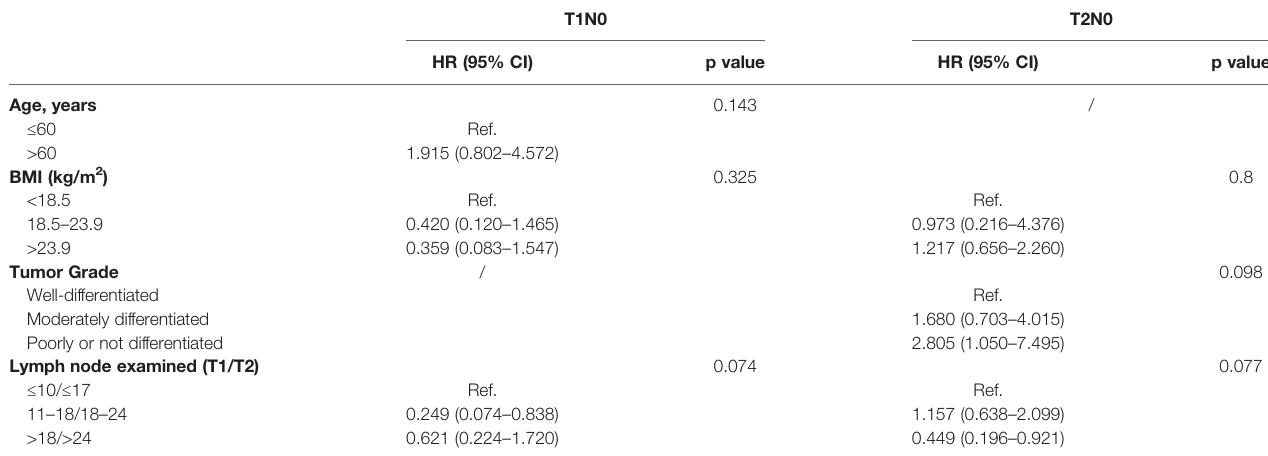
TABLE 2 | Multivariate analysis of T1N0 and T2N0 ESCC patients by Cox proportional regression model.